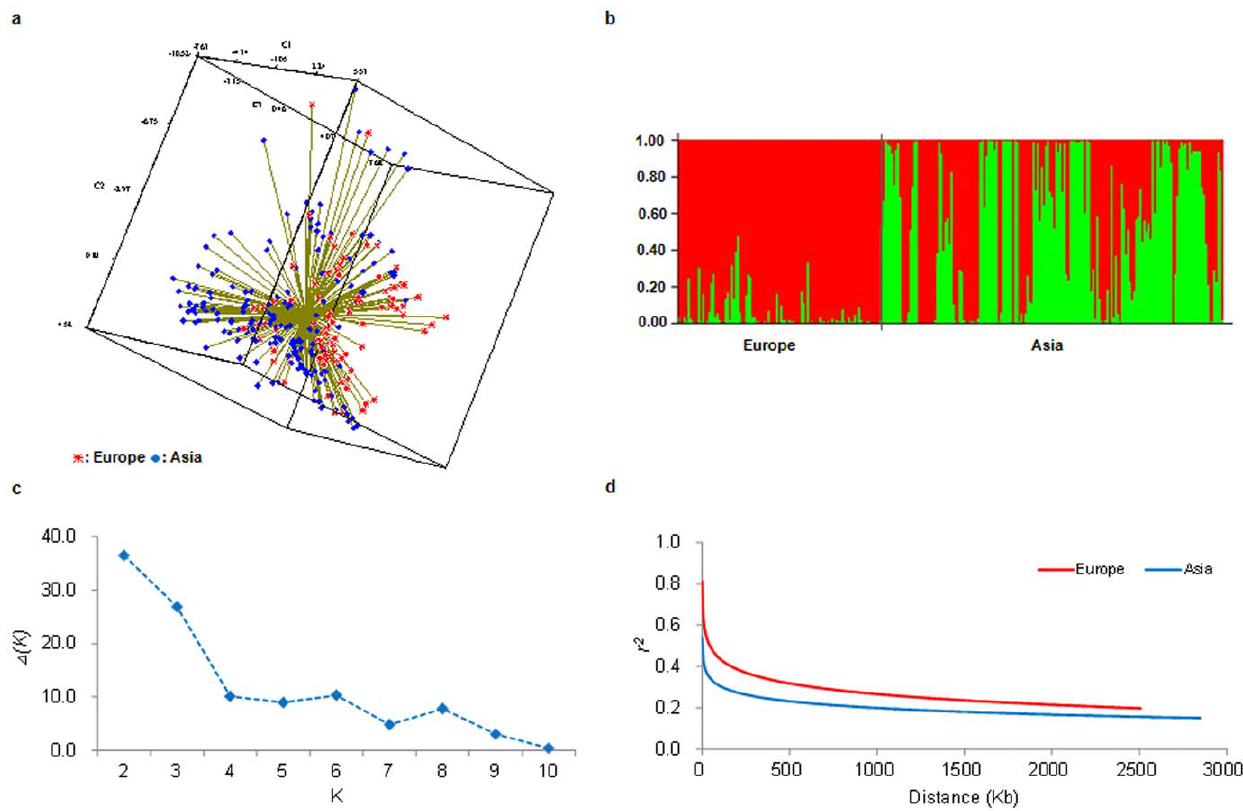
Figure 1. Analysis of genetic relationships, population structure and LD decay in European and Asian wheat accessions. (a) Principal coordinate analysis of European (red) and Asian (blue) accessions. (b) Bayesian clustering (STRUCTURE, K=2) of wheat accessions. (c) Estimation of the number of populations by calculating delta K values. (d) Average LD decay in European (red) and Asian (blue) accessions. doi:10.1371/journal.pone.0046444.g001 LDR. The number of significant associations was 4, 4, 1 and 3 for (DS) and disease index (DI), with 42 molecular markers (32 SSR and 10 SNP) along the 3.1-Mb region on chromosome 3BS. The results of the association studies, including the Manhattan and quantile-quantile plots, are mapped in the Figure 3 and Figure S2. Twelve significant association signals were found at the threshold of P , 0.05 (Table 4). No significant association was identified for